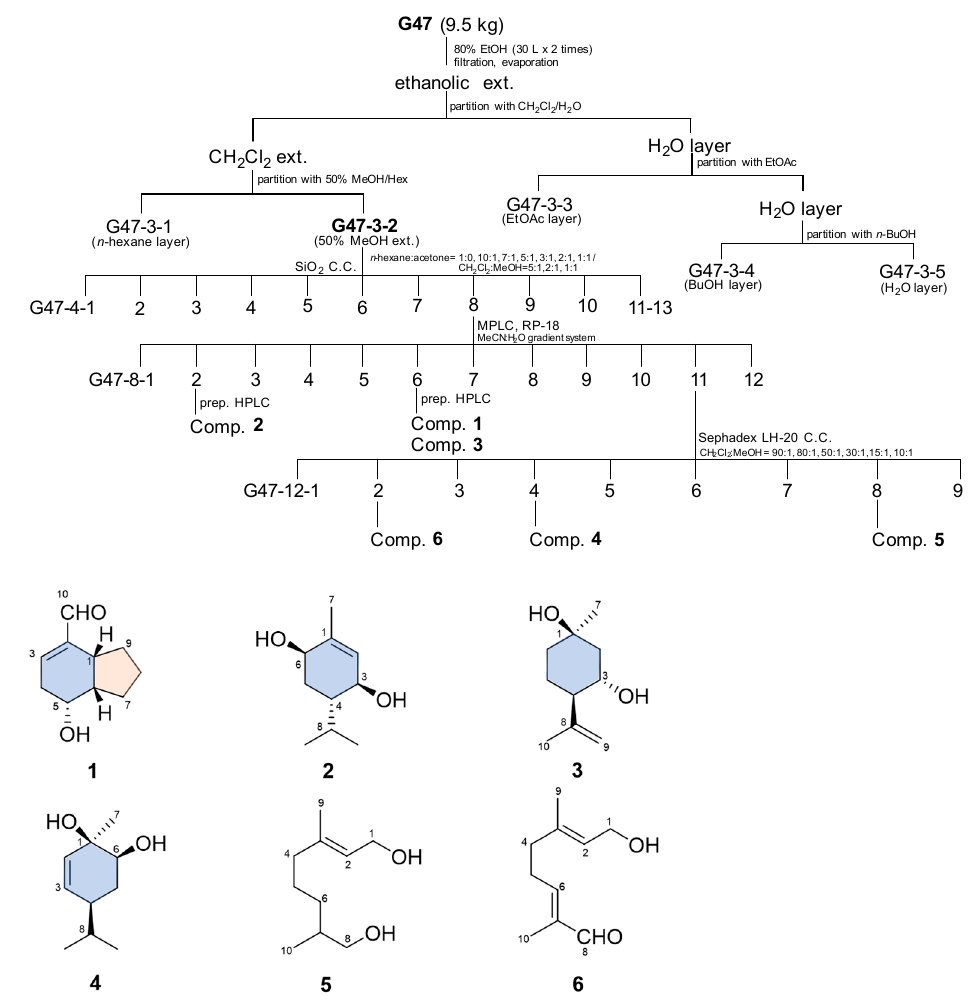
Figure 1. Fractionation flow map and structure of compounds isolated from the fruits of A. tsao-ko.